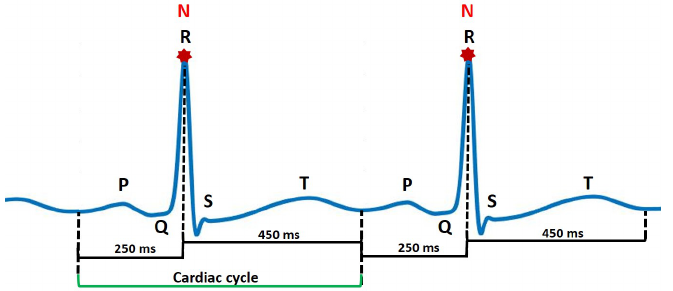
Figure 5. Cardiac cycle